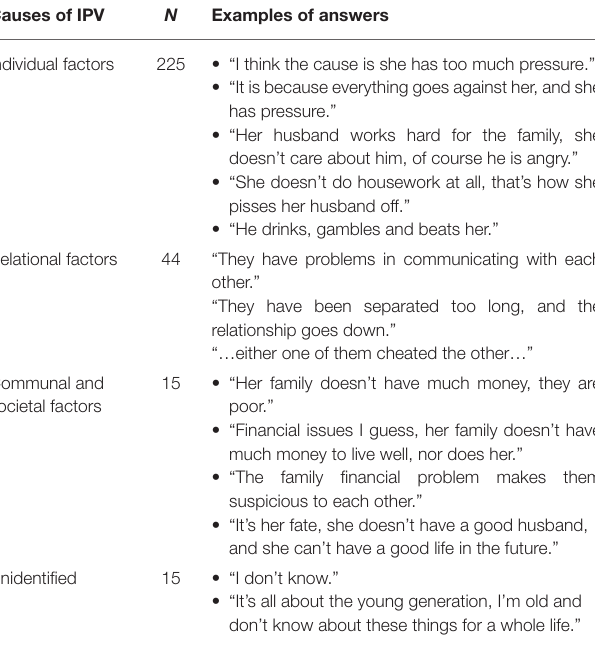
TABLE 1 | Participants’ characteristics and IPV experiences ( N = 339). Demographic information